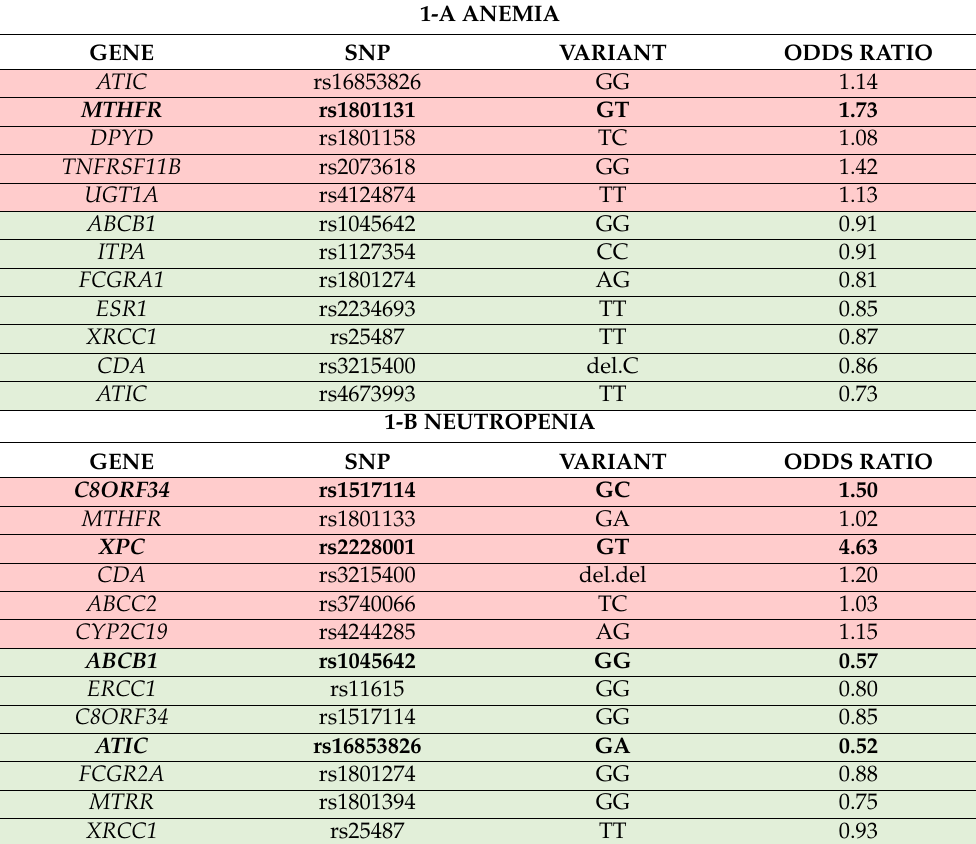
Table 1. Polymorphisms associated with toxicities. Those with protective effects are highlighted in green, while those with increased risk are highlighted in red. Panel 1-A includes results of anemia, Panel 1-B neutropenia and Panel 1-C, the results of thrombocytopenia. Bold-type values are those over 1.50 or under